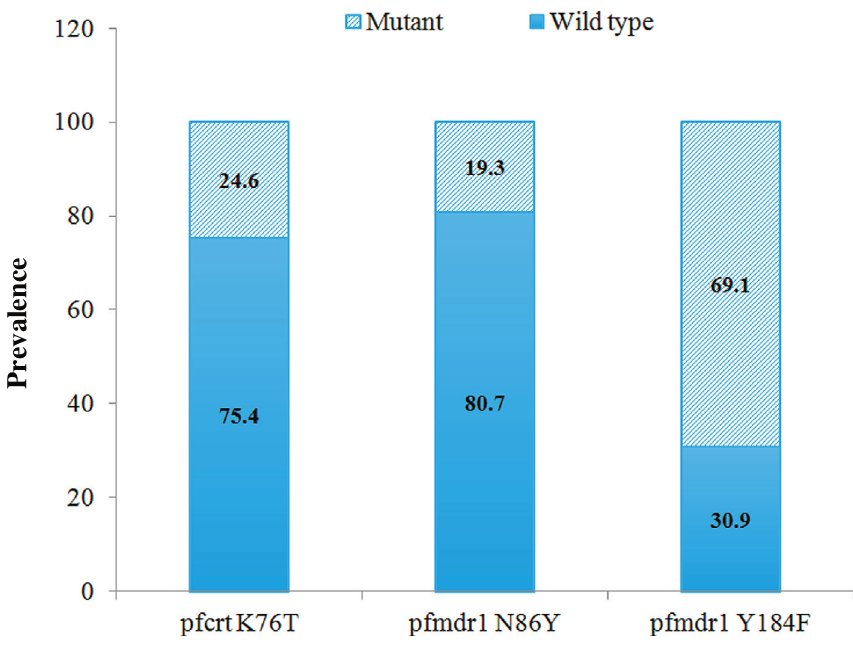
Figure 2. Prevalence of pfcrt and pfmdr1 polymorphisms.